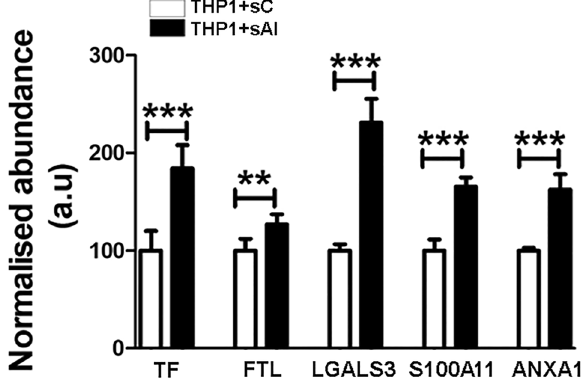
Figure 5. The normalized abundance changes of proteins induced by hyperlipidemic serum in THP-1 cells correlated with iron metabolism and DAMPs . Histogram highlighting the normalized abundance changes induced by hyperlipidemia in THP-1 cells exposed to normo-lipidemic serum (sC) or hyperlipidemic serum (sAl). TF and FTL are implicated in iron homeostasis, while LGALS3, S100A11 and ANXA1 are differentially abundant potential DAMPs. Data represent the mean ± SD; ** p < 0.01;*** p < 0.001). TF: serotransferrin; FTL: Ferritin light chain; LGALS3: galectin 3, S100A11: protein S100A11 and ANXA1: annexin